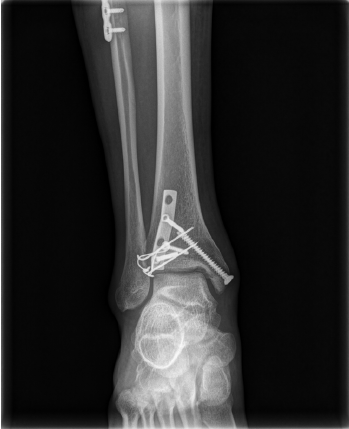
Figure 3. Stainless-steel wires are looped around the screw and the K-wires in a figure-of-eight man- ner.